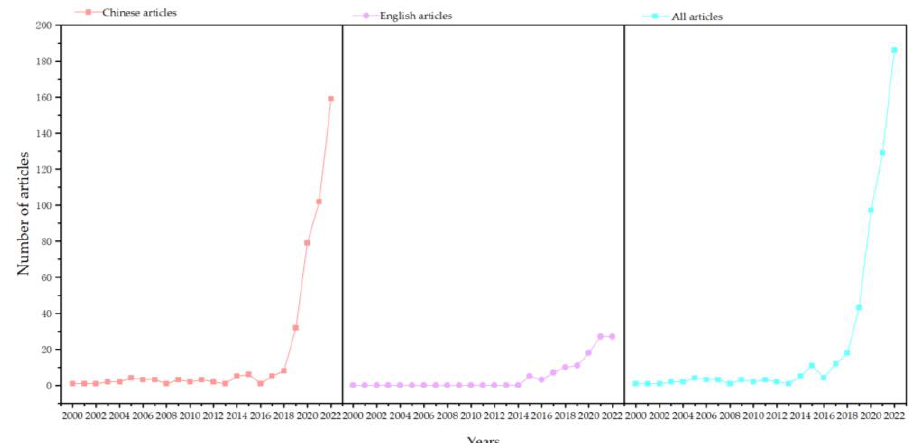
Figure 2. Annual distribution of articles.